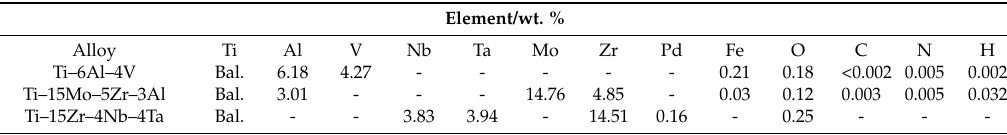
Table 4. Chemical composition of Ti-based